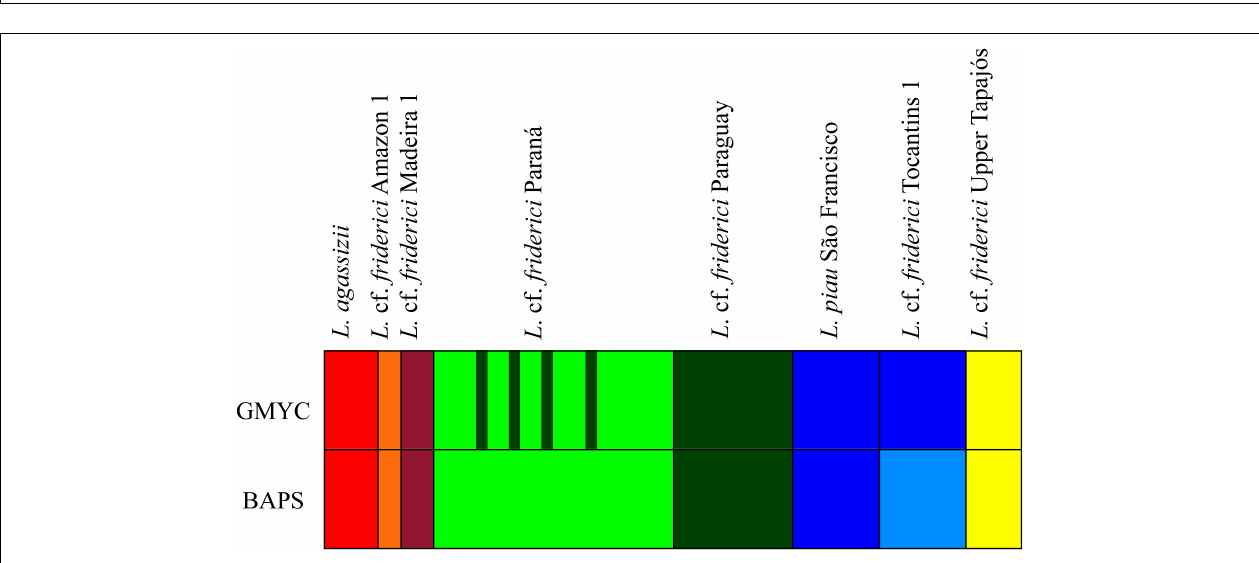
FIGURE 2 | Species tree showing phylogenetic relationships of Leporinus cf. friderici . Trees were generated using five molecular markers (sequences with approximately 4900 bp). The topology corresponds to Bayesian tree. The numbers on the branches are bootstrap values for maximum parsimony and maximum likelihood, and posterior probability for Bayesian species tree. The scale bar indicates nucleotide substitutions per site.